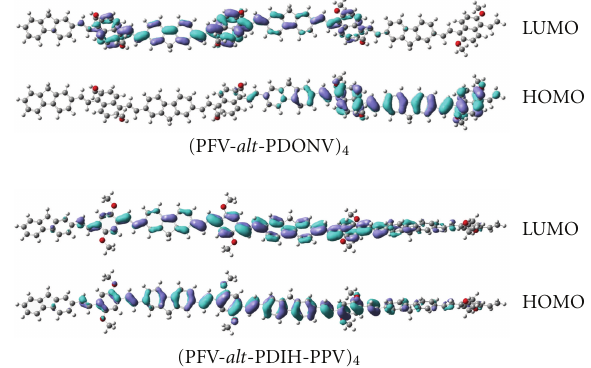
Figure 2: Frontier molecular orbitals of PFV- alt -PDONV and PFV- alt -PDIH-PPV ( n = 4) by B3LYP/6-31G(d).